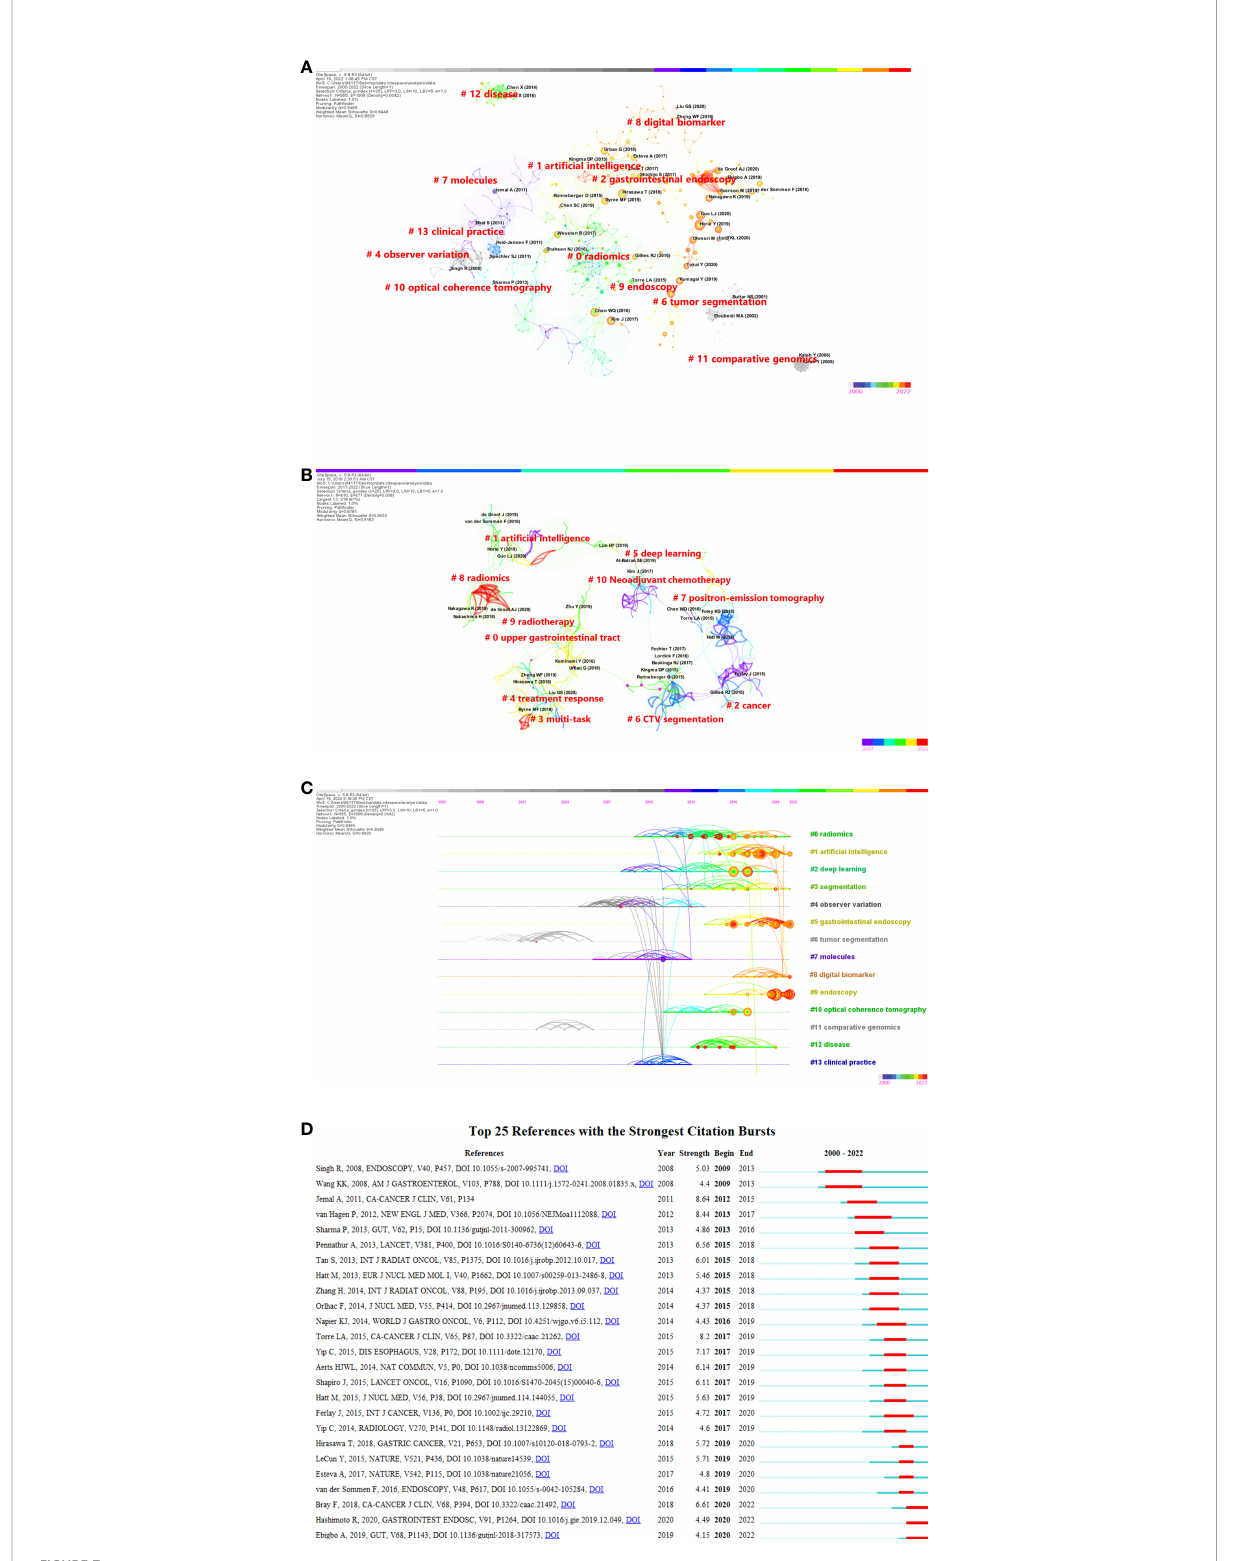
FIGURE 7 (A) Citespace visualization map of cluster view (cited references) (B) A landscape view of co-cited reference cluster analysis from 2017 to 2022. (C) CiteSpace visualization map of timeline view. The time evolution is indicated with different colored lines, and the nodes on the lines indicate the references cited. (D) CiteSpace visualization map of top 25 references with the strongest citation bursts from 2000 to